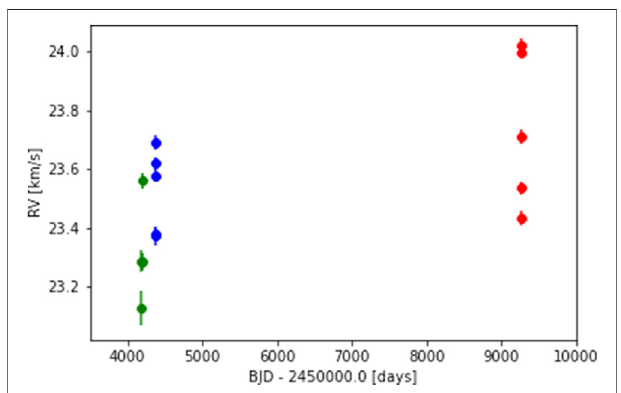
FIGURE 3 | Absolute radial velocities of CoRoT-1b. Data from the three observing runs are shown by different colors.